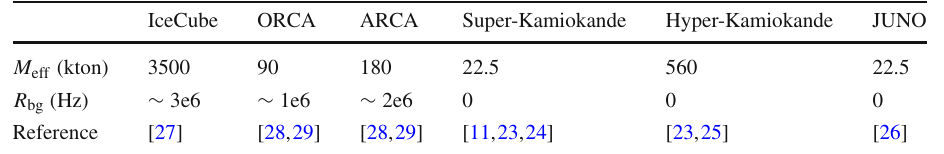
Table 1 Simplified detector characteristics used as input for the simulation: effective mass in water equivalent units and total background